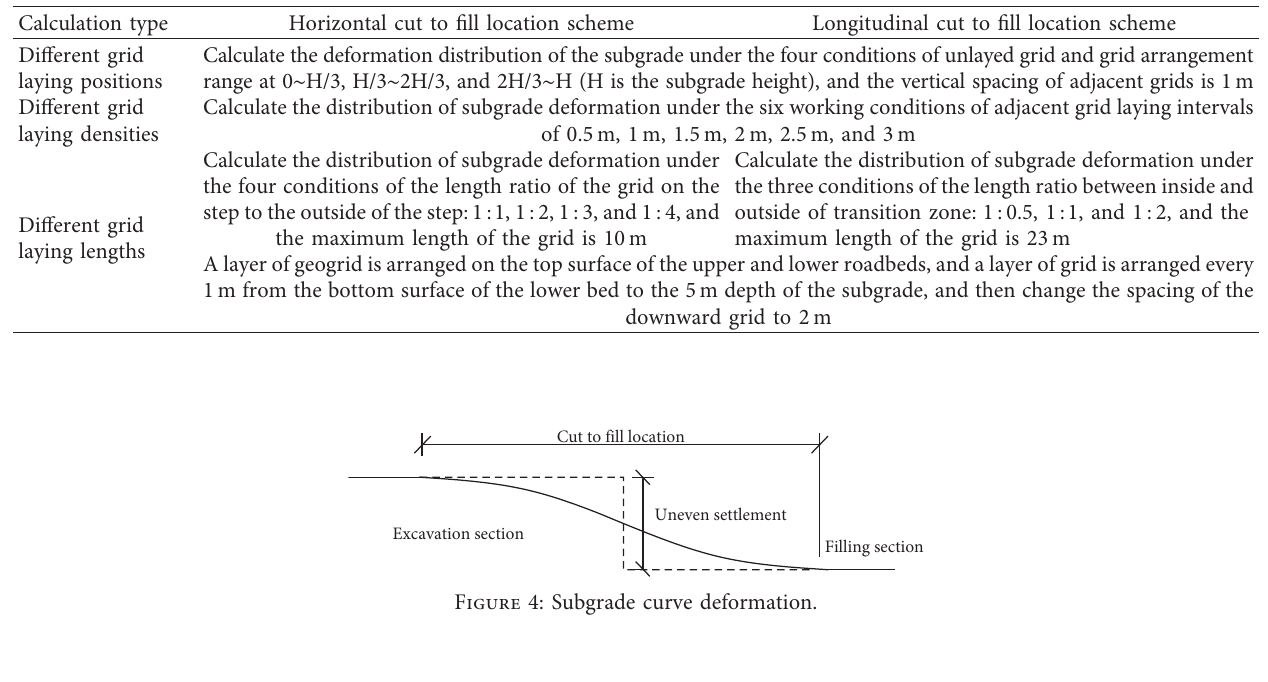
Table 5: Finite element calculation method for vertical and horizontal cut to fill location.